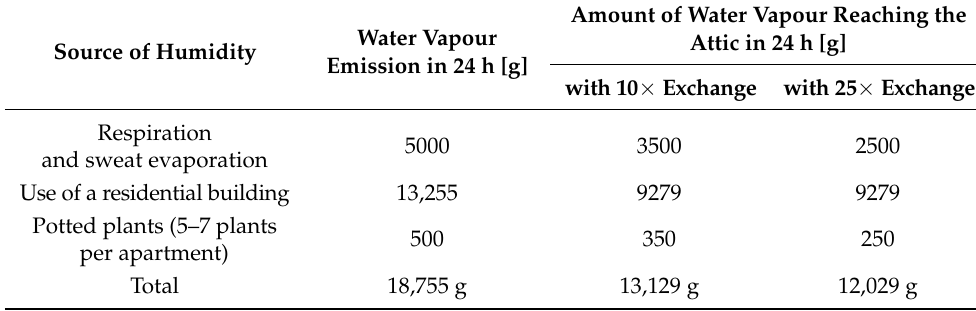
Table 2. Simulation of the source of humidity and the amount of water vapour—author’s summary